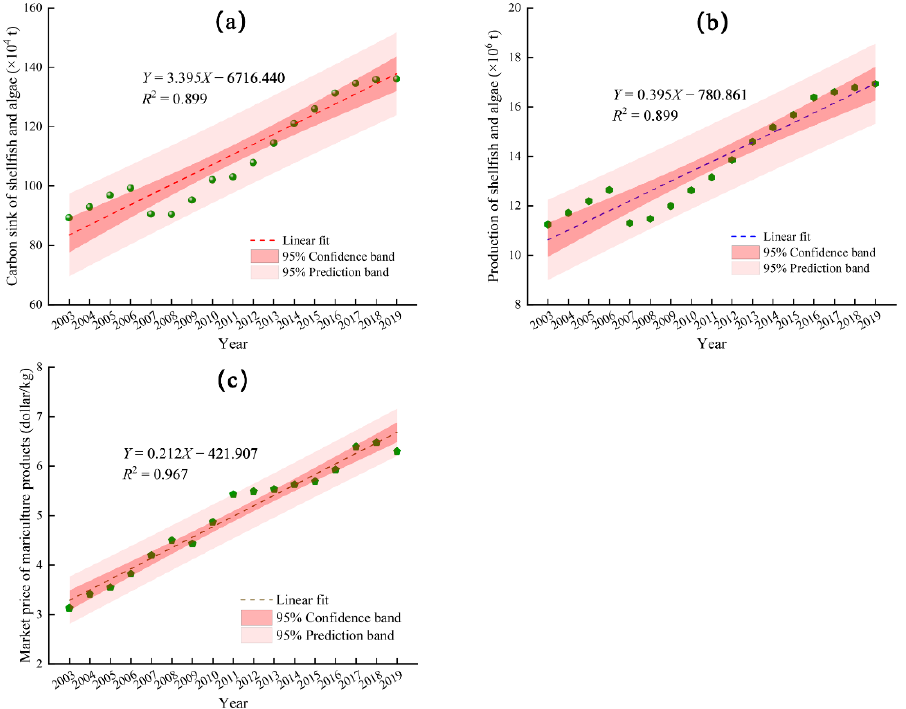
Figure 5. ( a ) Linear trend of the total shellfish and algae carbon sink over time; ( b ) linear trend of the total shellfish and algae mariculture production over time; ( c ) linear trend of the production price index of mariculture products over time.